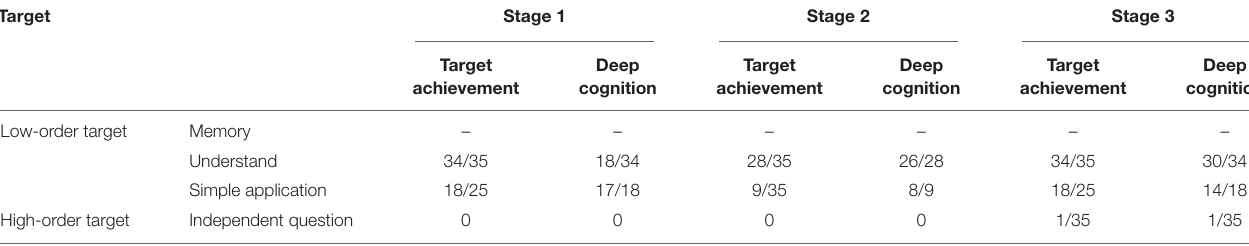
TABLE 4 | Analysis of the three-stage text tasks of the students in a flipped classroom mode.